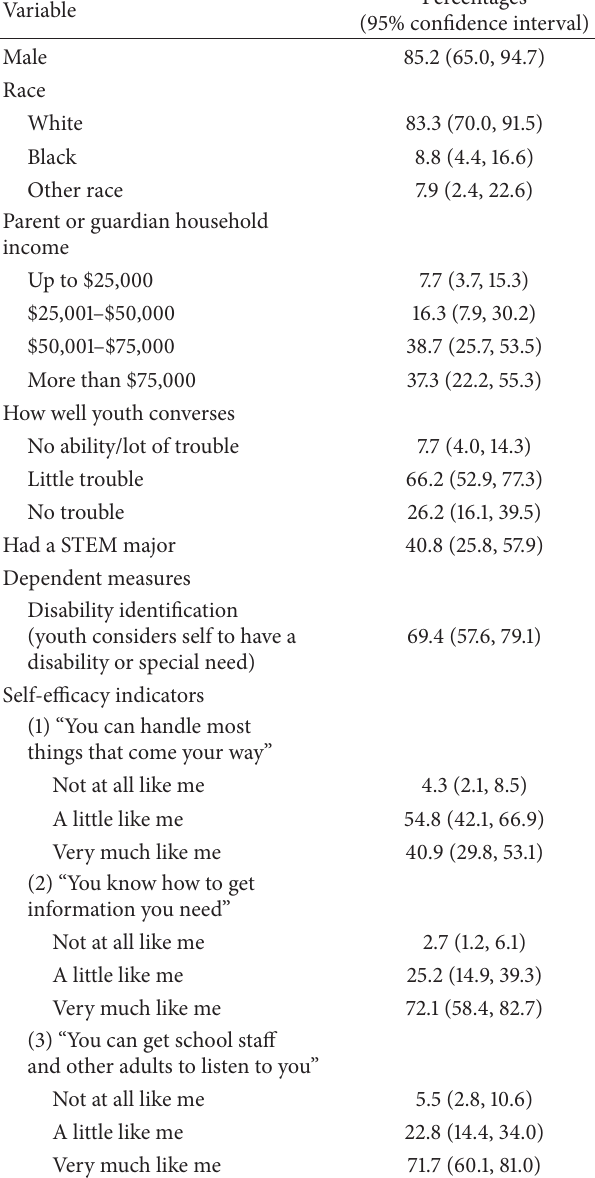
Table 1: Characteristics of college students on the autism